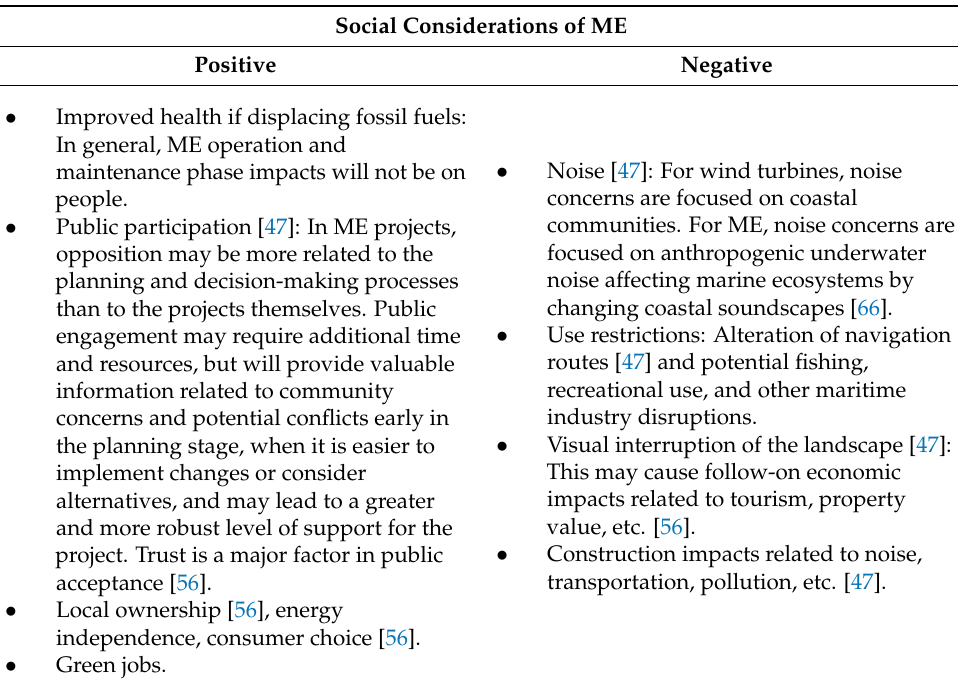
Table 1. ME deployment incurs various positive and negative effects on the surrounding community. This table provides a high-level summary of the potential social effects of ME deployment. However, communities are as unique as potential ME devices, and they have varied perceptions and values, so analysis should be developed with stakeholder